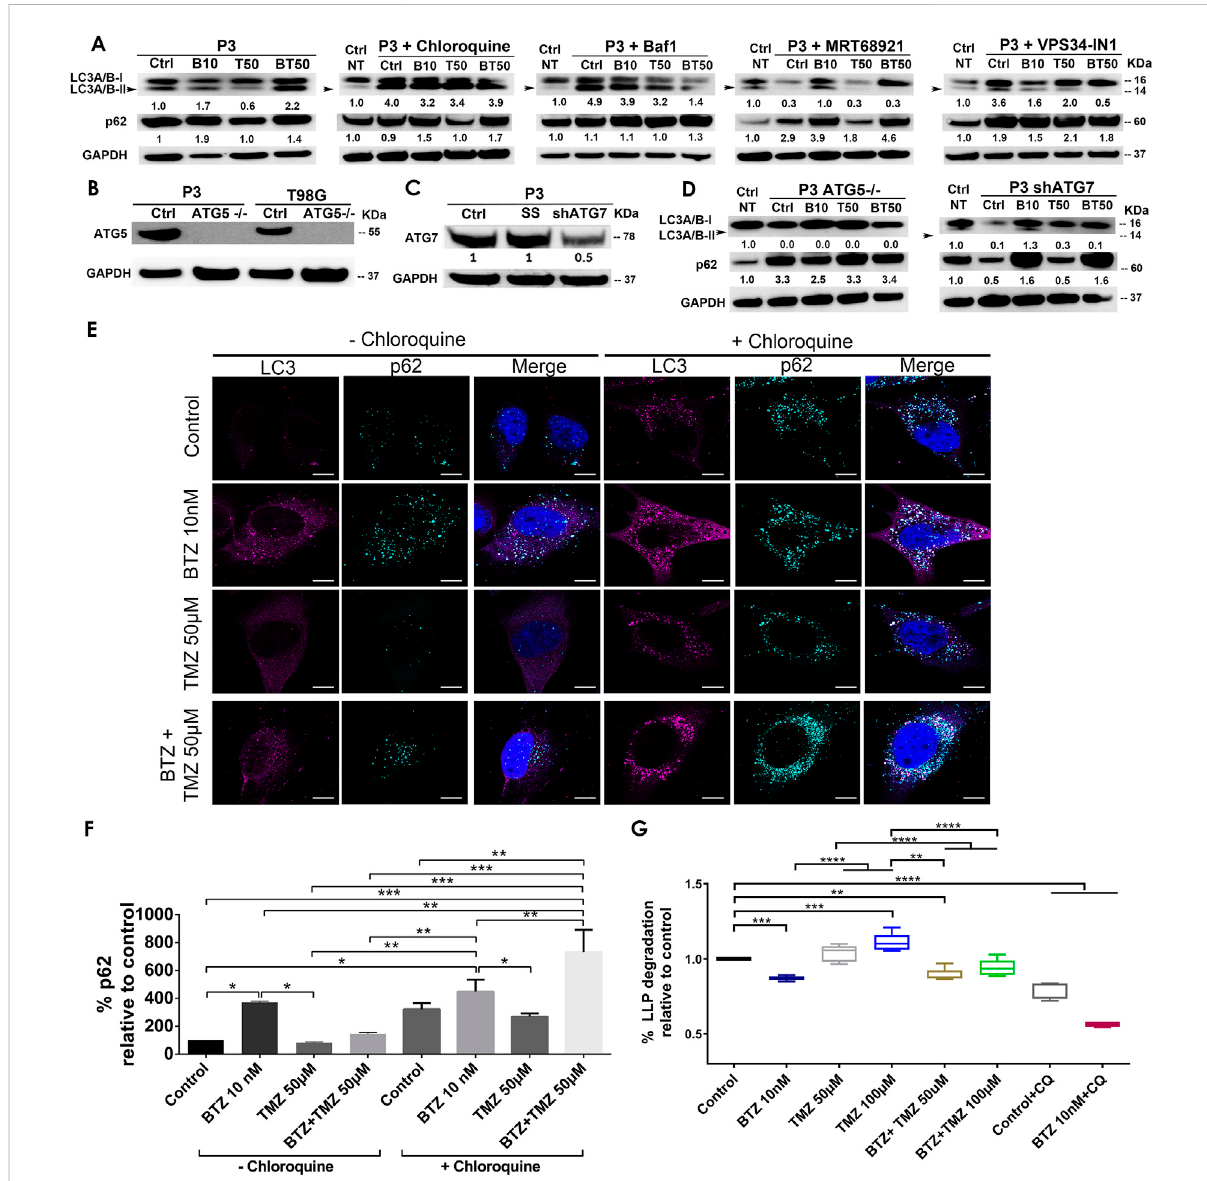
FIGURE 2 BTZ and combination BTZ + TMZ treatment accumulates LC3A/B-II and p62 (SQSTM1) in patient derived GBM cells. (A) Western blot of the indicated proteins inlysates ofwildtypeP3cells and P3cells treatedwith 10 nM BTZ(B10), 50 μ MTMZ (T50)or both(BT50) or inacombinationwith autophagy inhibitors (chloroquine, Ba fi lomycin A1 (BafA1), MRT68921 or VPS34-IN1). (B,C) Western blot of the indicated proteins in lysates of wild type P3, T98G cells and cells lacking ATG5 ( ATG5 − / − ) , scrambled shRNA (SS) and ATG7 (shATG7). (D) Western blot of the indicated proteins in lysates of wild type P3 cells lacking ATG5 ( ATG5 − / − ) or ATG7 (shATG7), treated with 10 nM BTZ (B10), 50 μ M TMZ (T50) or both (BT50). GAPDH was usedasaloadingcontrolandfornormalizingdensitometrymeasurementsoftheblots.CtrlNT=non-treatedcontrolcells. (E) Confocalmicroscopy of P3 cells stained with antibodies against LC3A/B and p62 (SQSTM1) after the indicated treatments in the absence (left panel) or presence (right panel) of chloroquine (CQ), scale bar 10 μ m. (F) Quanti fi cation of p62 (SQSTM1) puncta after the indicated treatments in the absence or presence